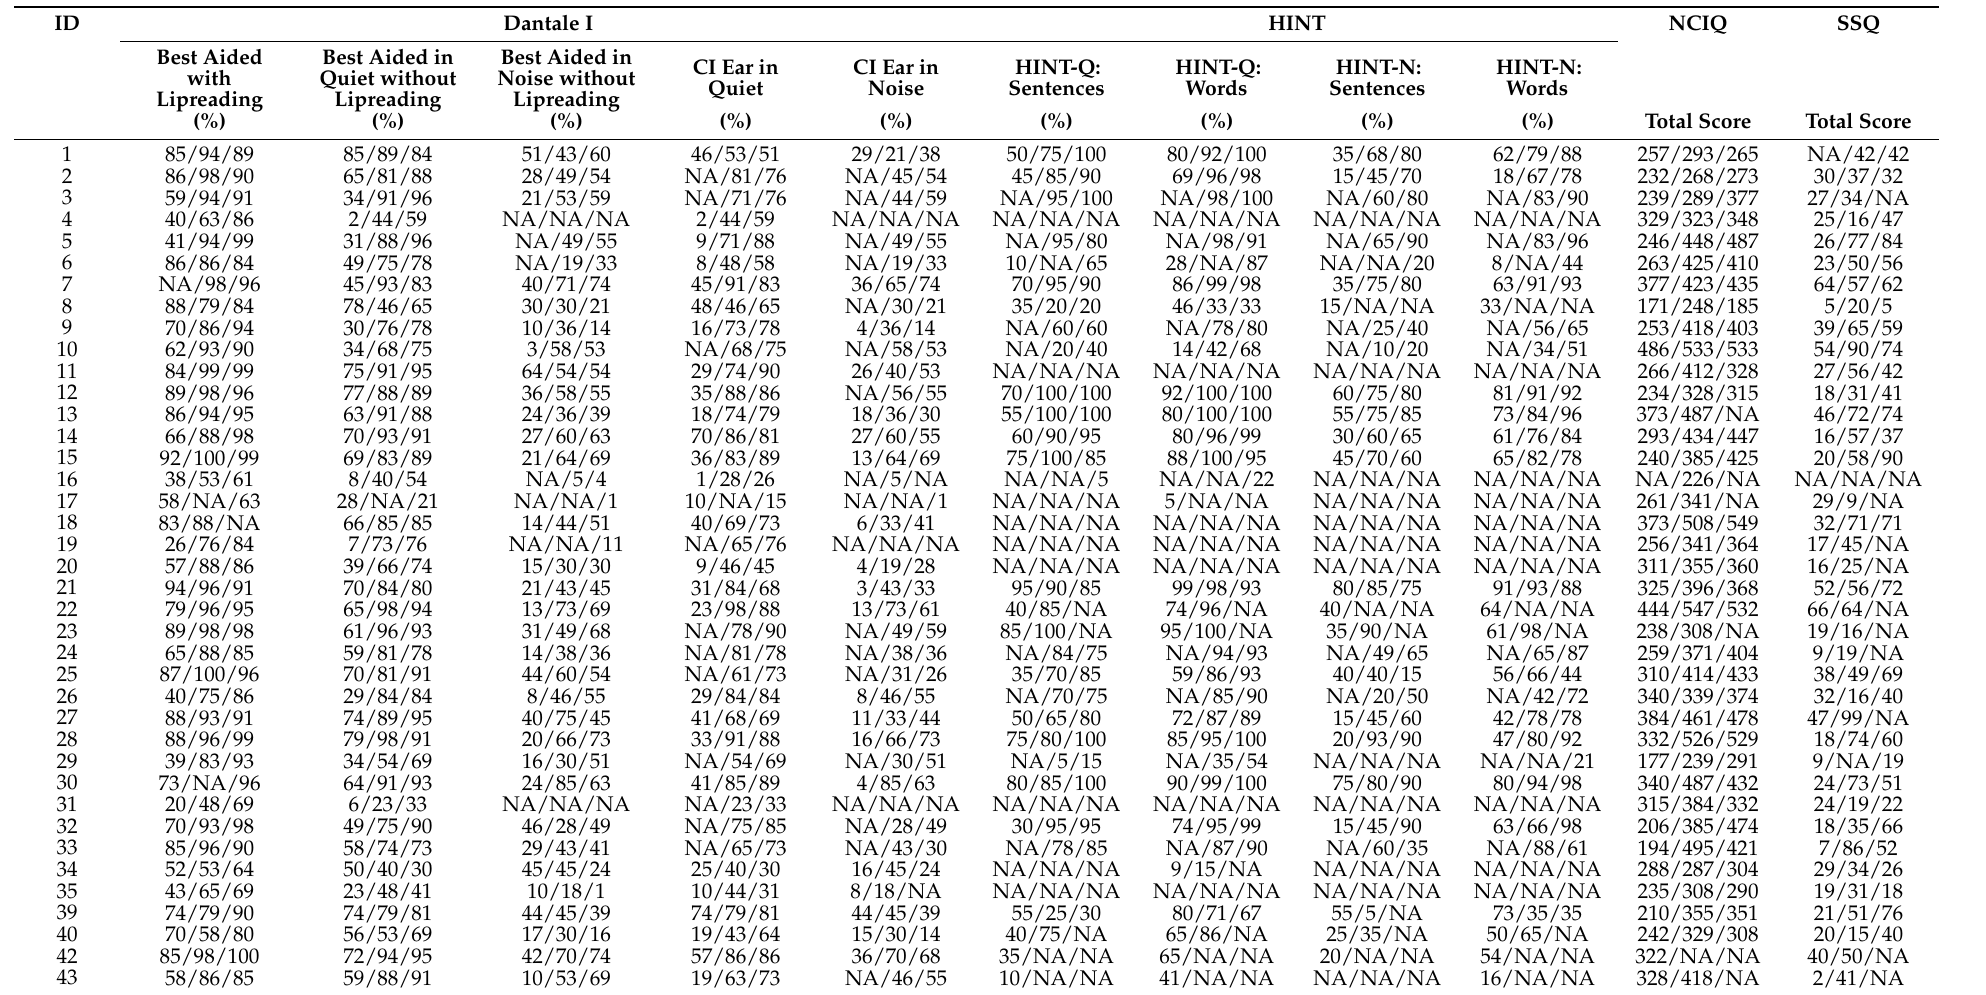
Table 3. Individual patient outcomes for audiometric test measures (Dantale I and HINT) and patient-reported outcome measures (NCIQ and SSQ) at